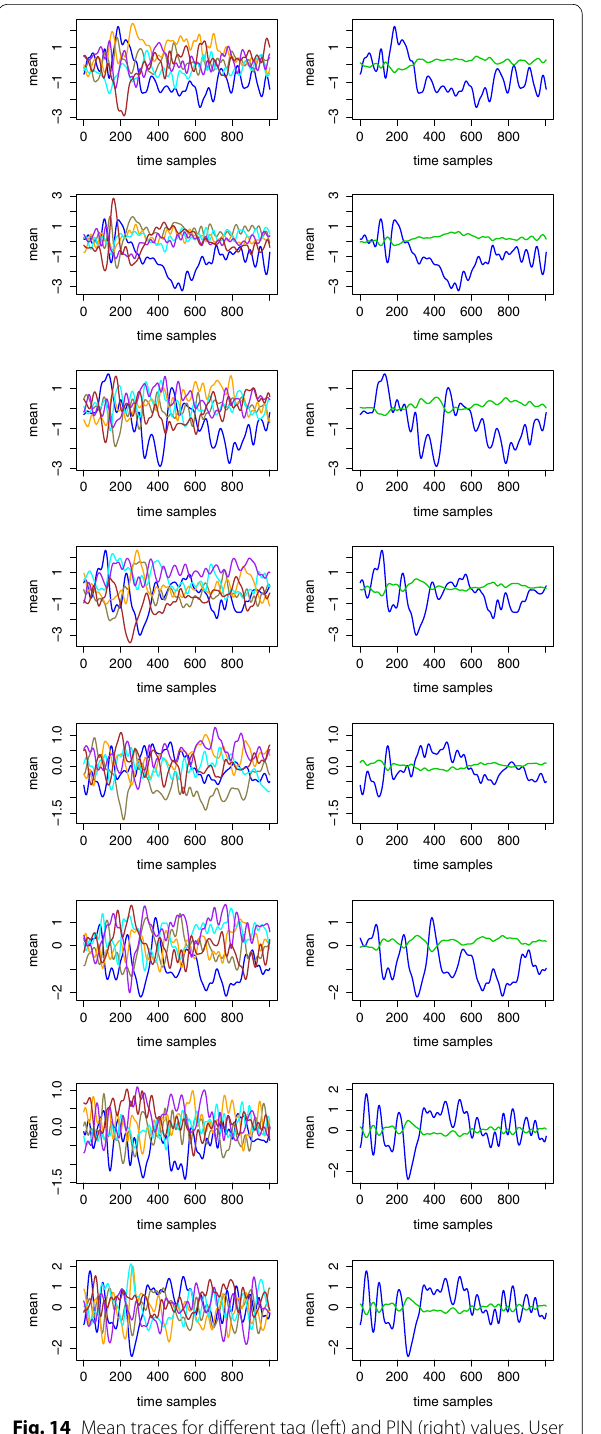
Fig. 14 Mean traces for different tag (left) and PIN (right) values. User 1 (top) to 8 (bottom), Electrode P8